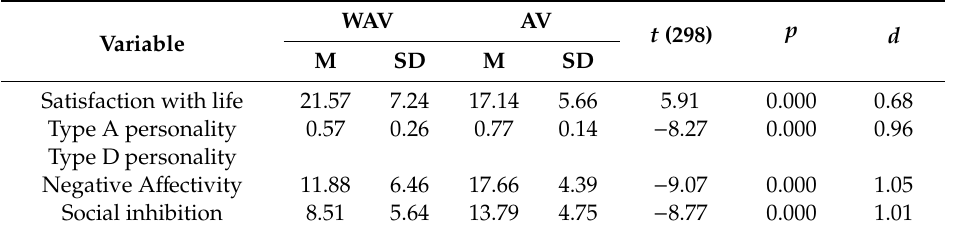
Table 2. Di ff erences between the without acne vulgaris (WAV) and acne vulgaris (AV) samples in terms of life satisfaction, Type A behavior pattern (TABP), and Type D personality.